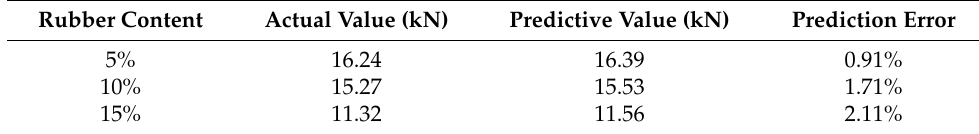
Table 14. Rise-time–amplitude (RA) two-parameter neural network prediction results. Rubber